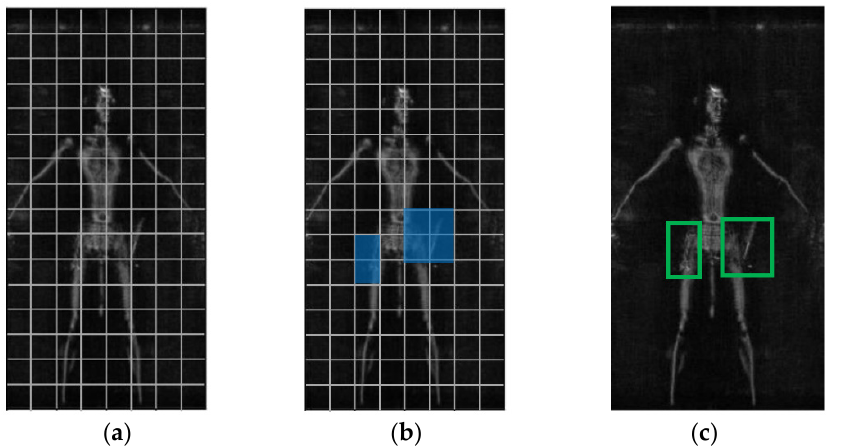
Figure 6. Recognition process of yolov3. ( a ) Grid image. ( b ) Classification and box prediction net. ( c ) Result image.